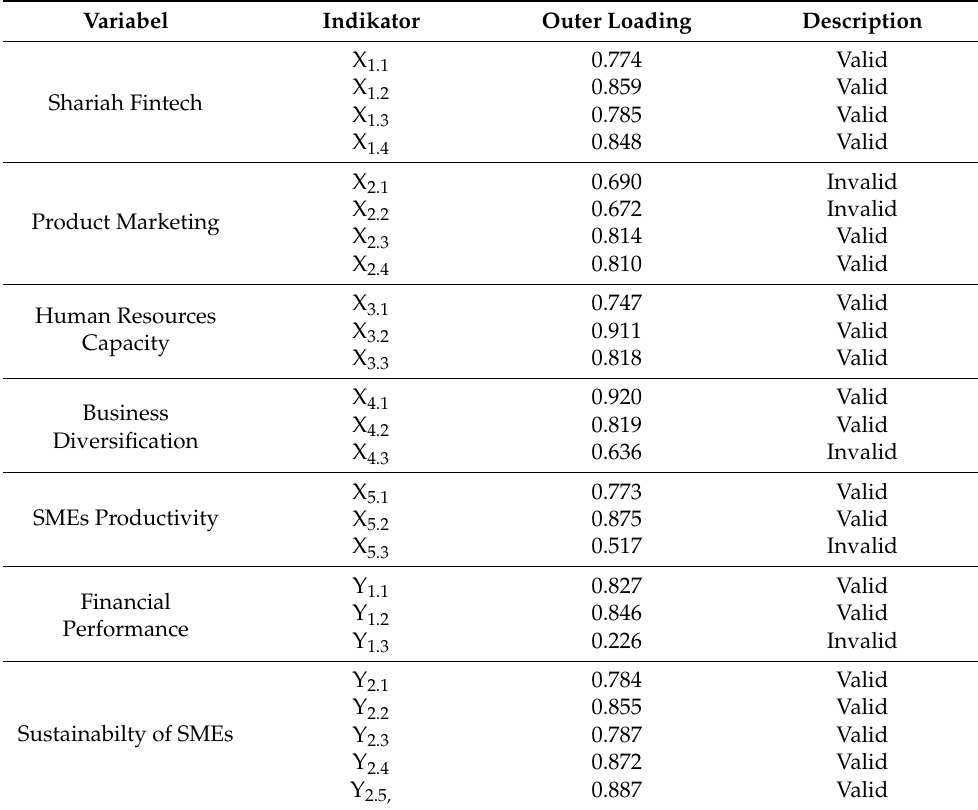
Table 3. Construct validity test